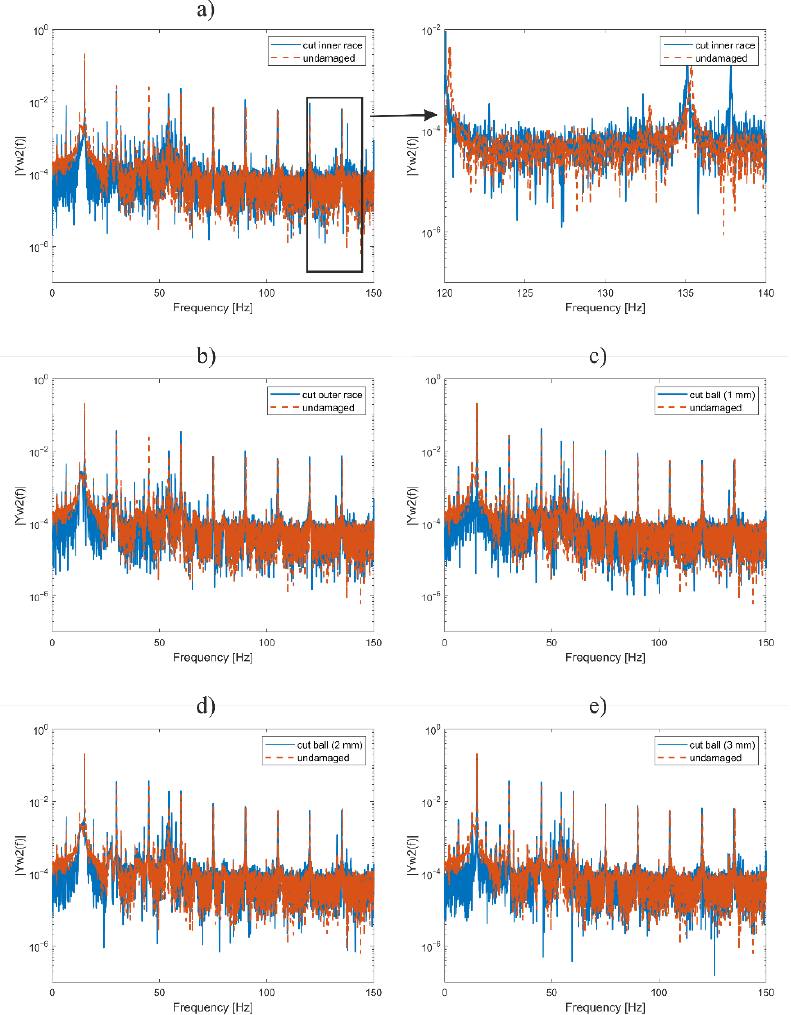
Figure 5. The FFT analysis of the recorded shaft displacement signal influenced by the vibration signal coming from bearing (brake side) SKF 1207K: ( a ) with cut inner race; ( b ) with cut outer race; with the cut ball at the depth of: ( c ) 1 mm; ( d ) 2 mm; ( e ) 3 mm.